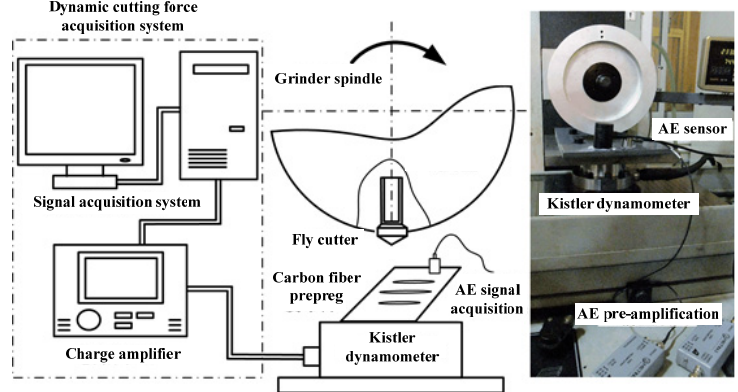
Figure 5. Configuration diagram of single point cutting of carbon fiber prepreg materials.